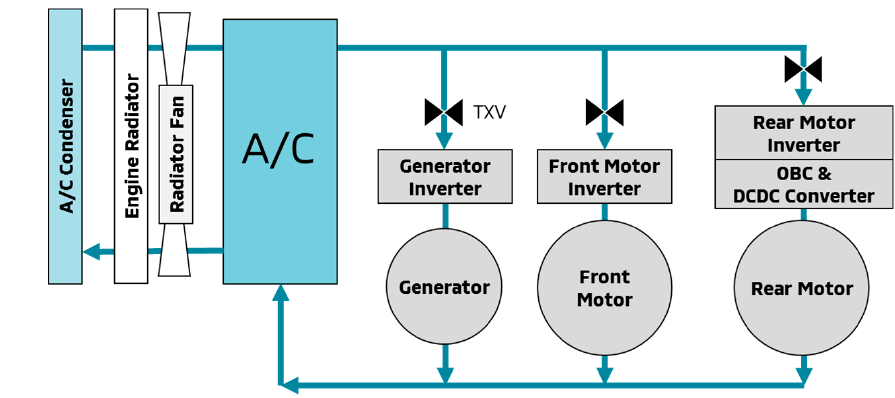
Figure 2. ( a ) Current cooling system of PHEV; ( b ) one example of ideal cooling systems using refrigerant cooling.